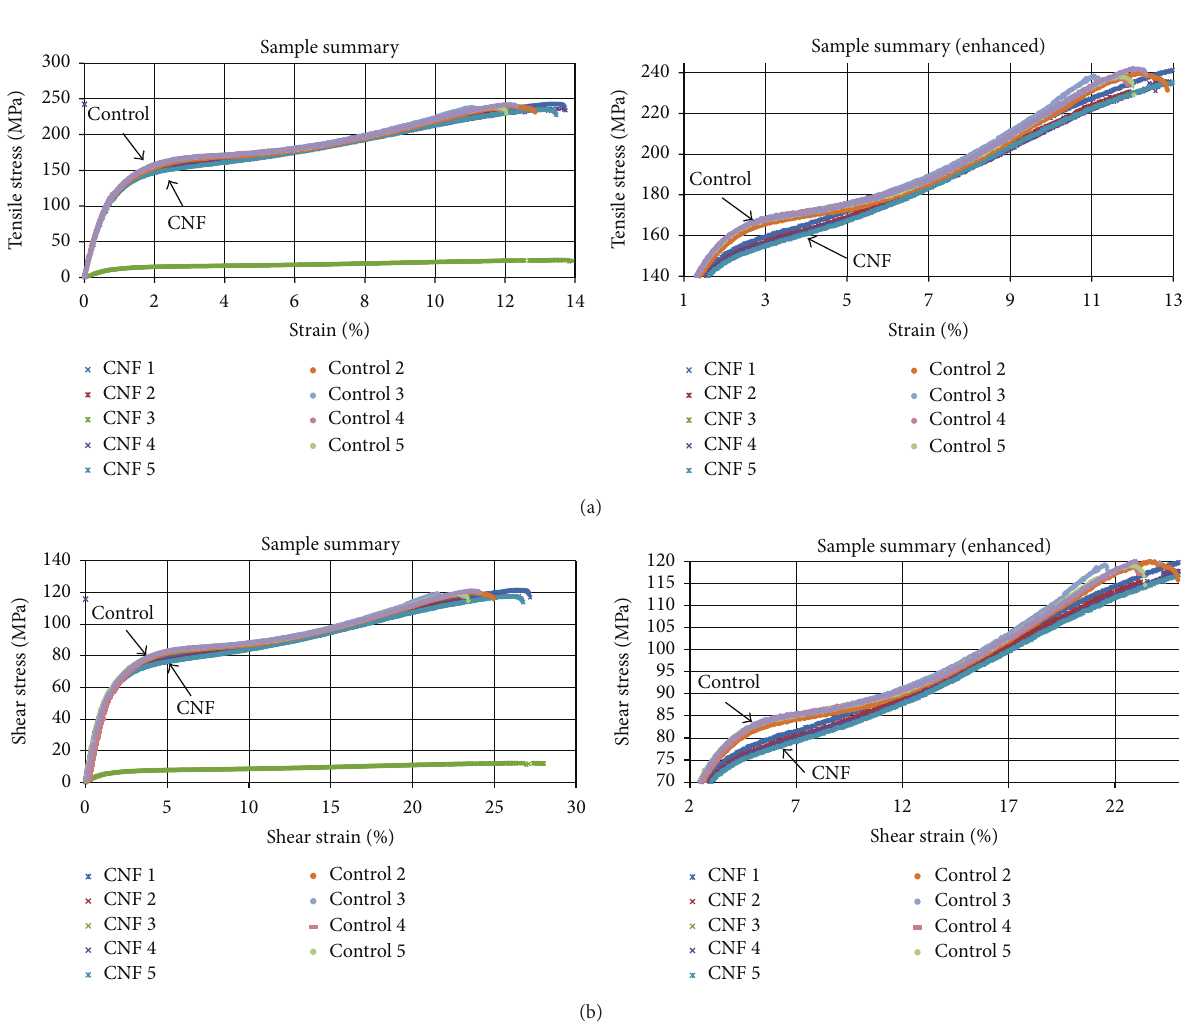
Figure 3: Enhanced side-views show delamination in control samples (a) and localized failure in CNF modified samples (b).